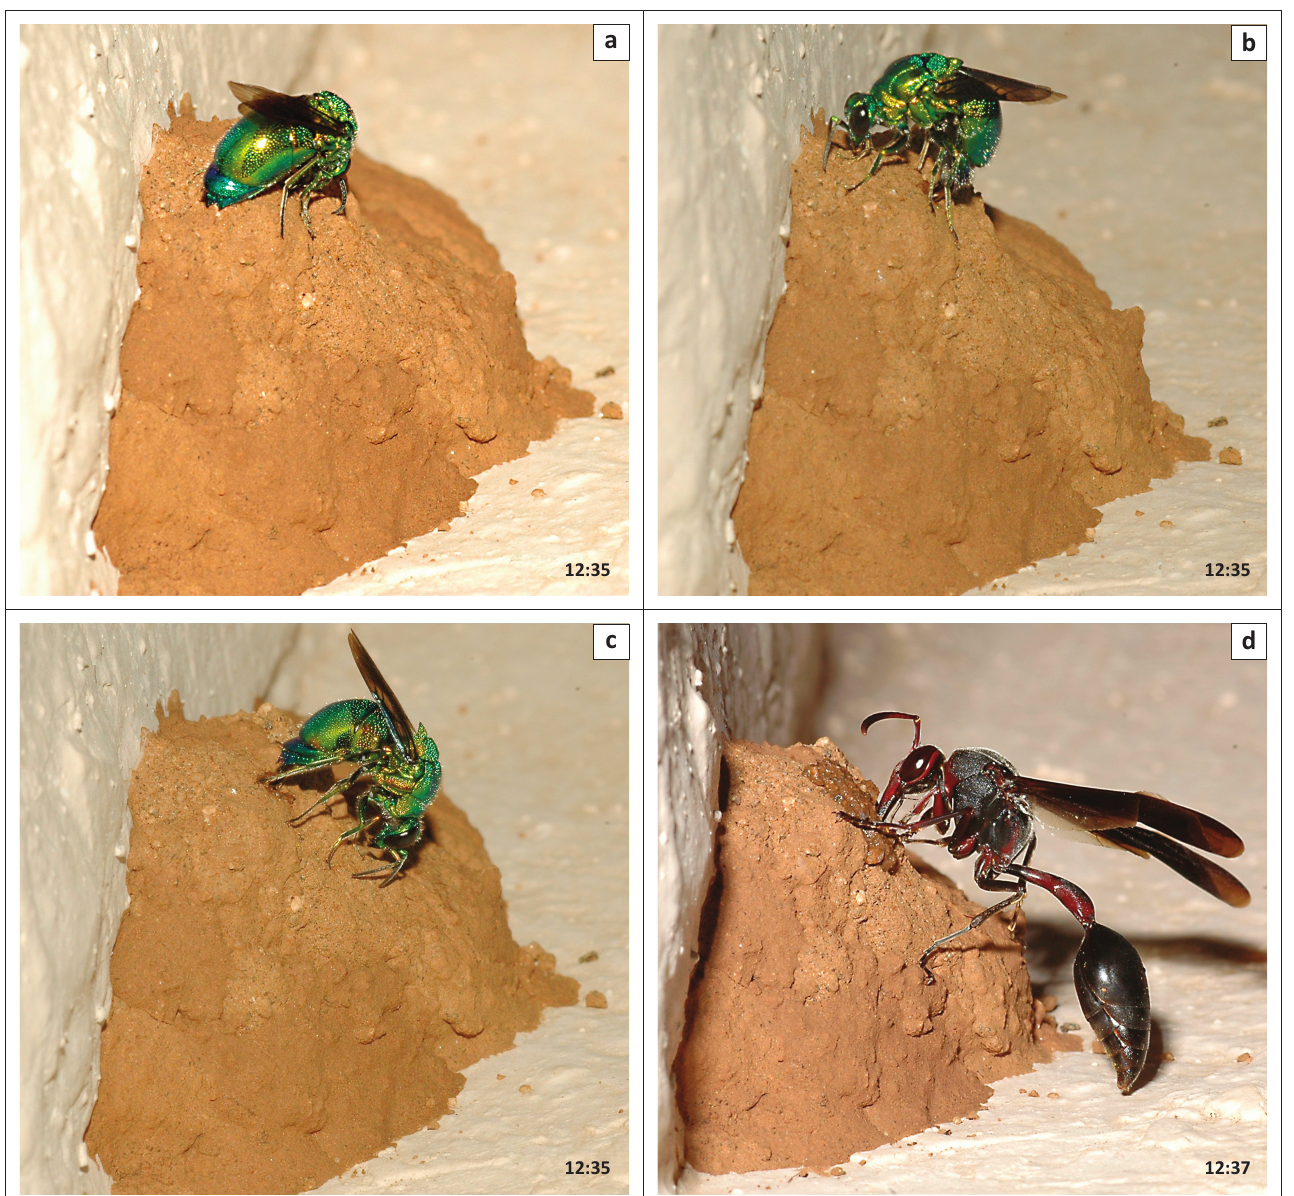
FIGURE 2: Stilbum cyanurum wasps ovipositing into the Delta sp. nest. Photograph times are included to illustrate the sequence of oviposition instances. The S. cyanurum would first chew a hole in the mud (a), before turning around and inserting her ovipositor (b). While straining to penetrate the mud wall, the S. cyanurum would sometimes rotate around her ovipositor (b)-(c). Oviposition was always terminated by the return of the Delta sp., who would immediately chase the S. cyanurum off the nest and then repair the holes made by the ovipositing S. cyanurum wasps ([d], note the wet mud). Only one S. cyanurum was observed to oviposit at any given time, although the second individual was sometimes perched alongside on the nest ([e], the individual on the right is ovipositing). The S. cyanurum wasps were still ovipositing in the same part of the nest during the second observation period approximately 1.5 hours later ([f], note the additional layers of mud added to this part of the nest in the